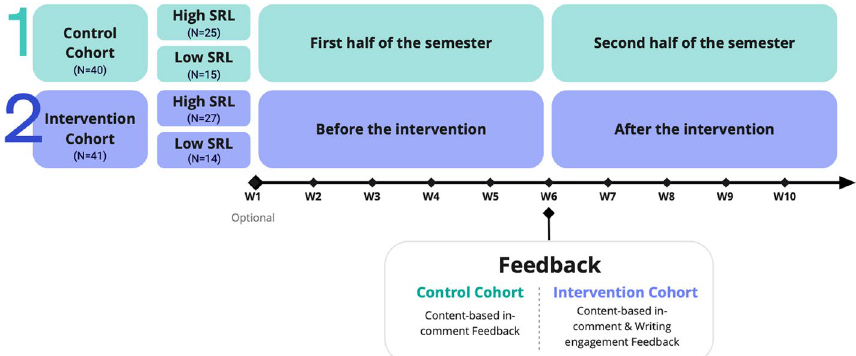
Fig. 1 Overview of the study and feedback intervention across clusters of